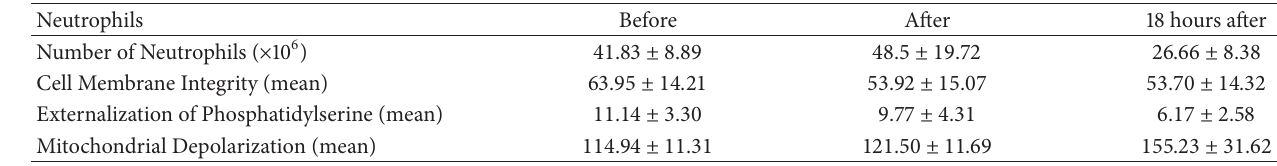
Table2:Effectsofaclassicalballetclassonneutrophilnumbers,membraneintegrity,externalizationofphosphatidylserineandmitochondrial depolarization before, immediately after and 18 hours after a ballet class.